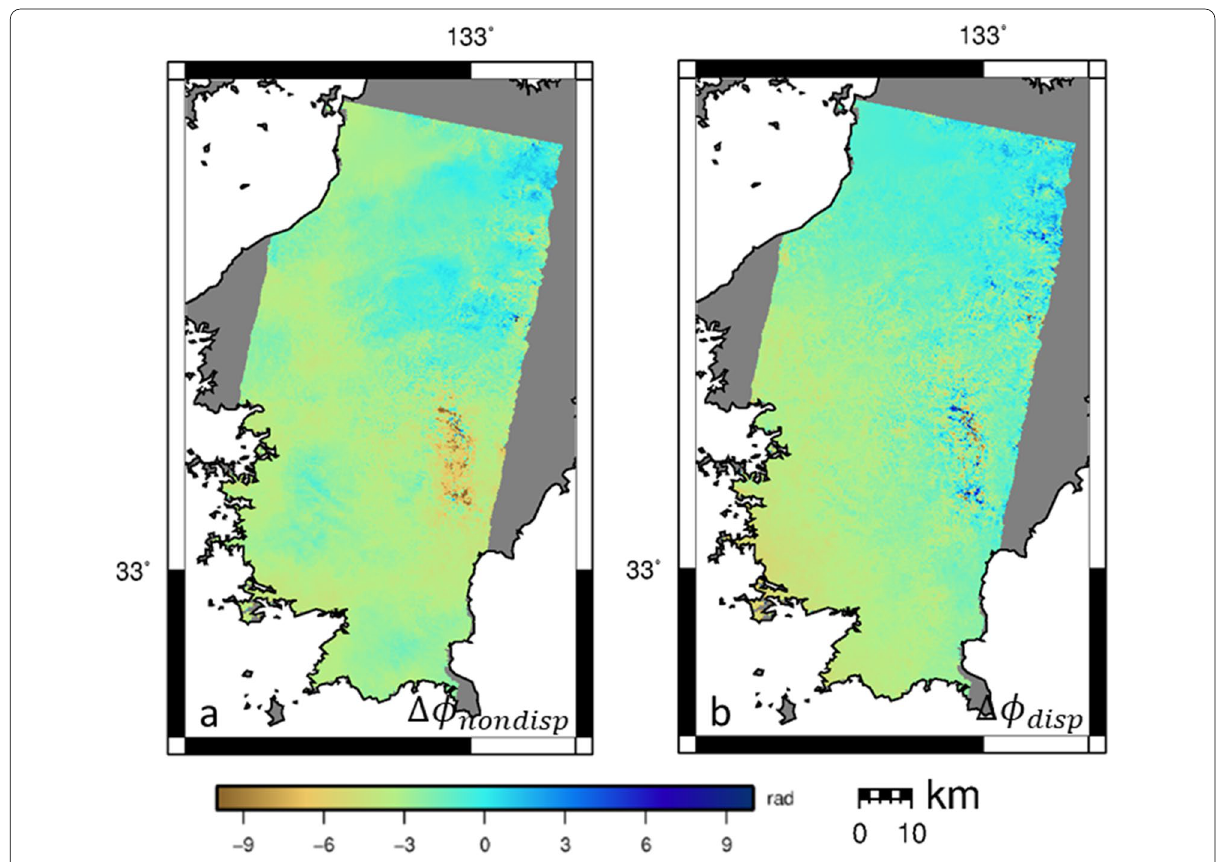
Fig. 4 Retrieval of standard SSM on Shikoku 20180815_20181107. a �φ non-dispersive and b �φ